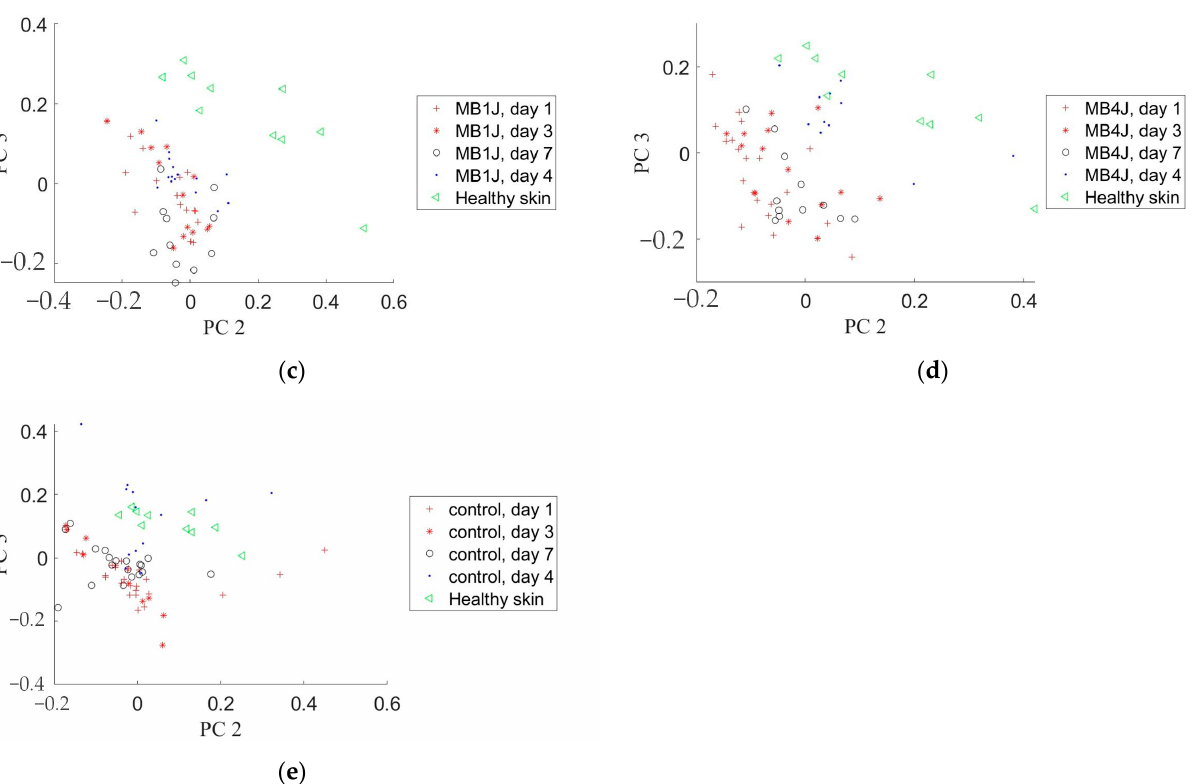
Figure 15. Principal component analysis of the wound and healthy skin Raman spectra in the 2800–3000 cm − 1 spectral range on different observation days in a subspace of PC2 and PC3: ( a ) 5-ALA 1 J/cm 2 group, ( b ) 5-ALA 4 J/cm 2 group, ( c ) MB 1 J/cm 2 group, ( d ) MB 4 J/cm 2 group, ( e ) the control group.